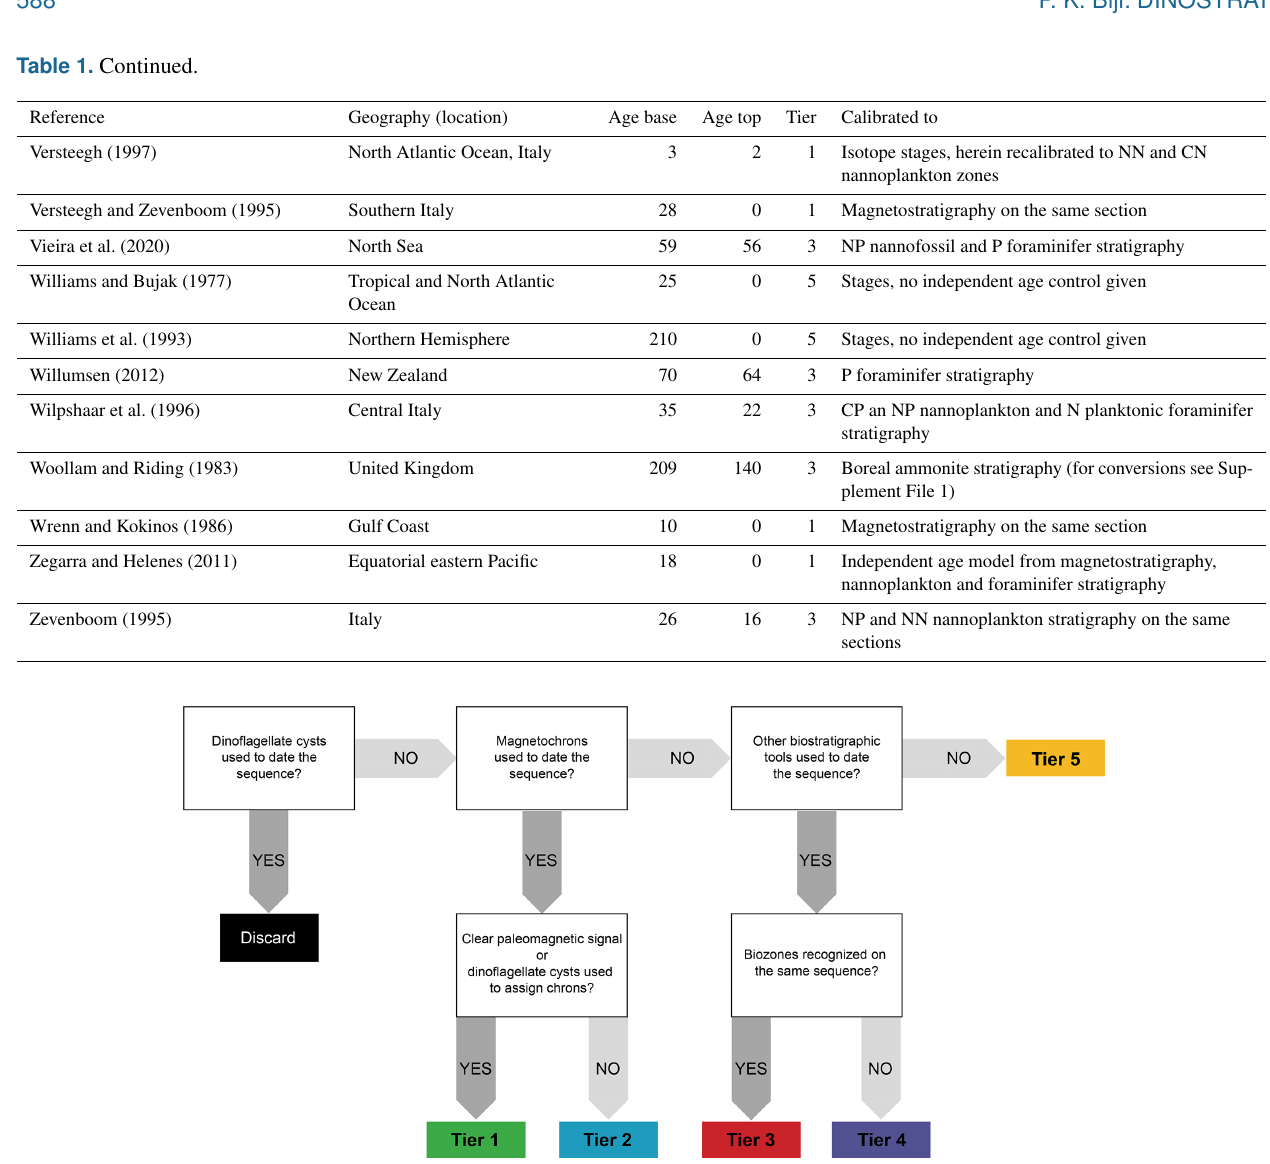
Figure 1. Decision tree for including studies in this review and categorization criteria for the five tiers.